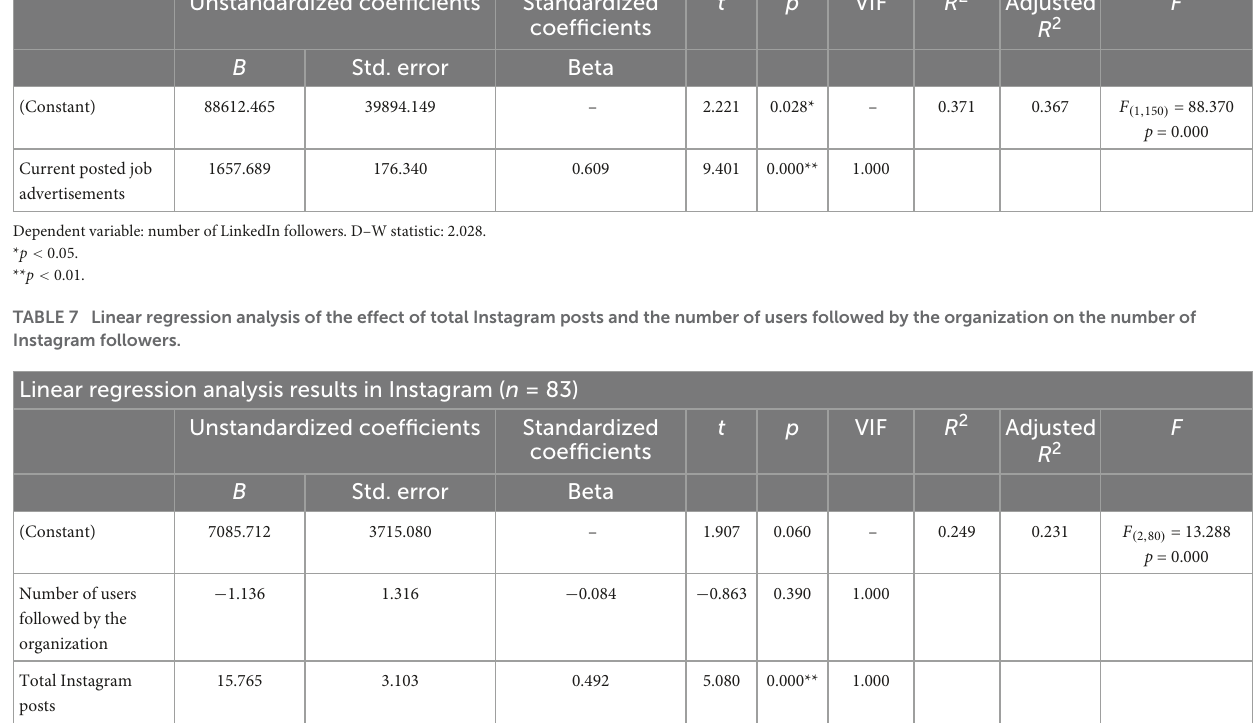
TABLE 6 Linear regression analysis of the effect of current posted job advertisements on the number of LinkedIn followers. Linear regression analysis results in LinkedIn ( n = 152)